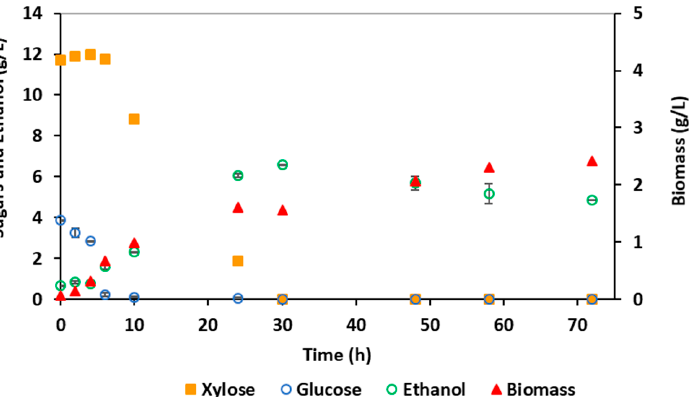
Figure 2. Time course of S. stipitis fermentation using the YPM synthetic medium, glucose, xylose, bioethanol and biomass concentrations (50 mL, 150 rpm, initial pH 5.5 and 30 °C). bioethanol and biomass concentrations (50 mL, 150 rpm, initial pH 5.5 and 30 ◦ C).